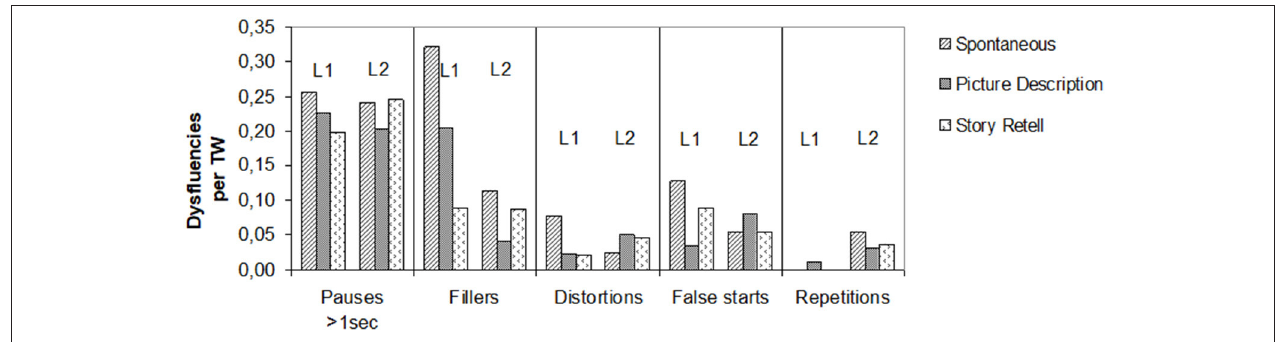
FIGURE 2 | Dysfluencies per total words (TW) in L1 and L2.